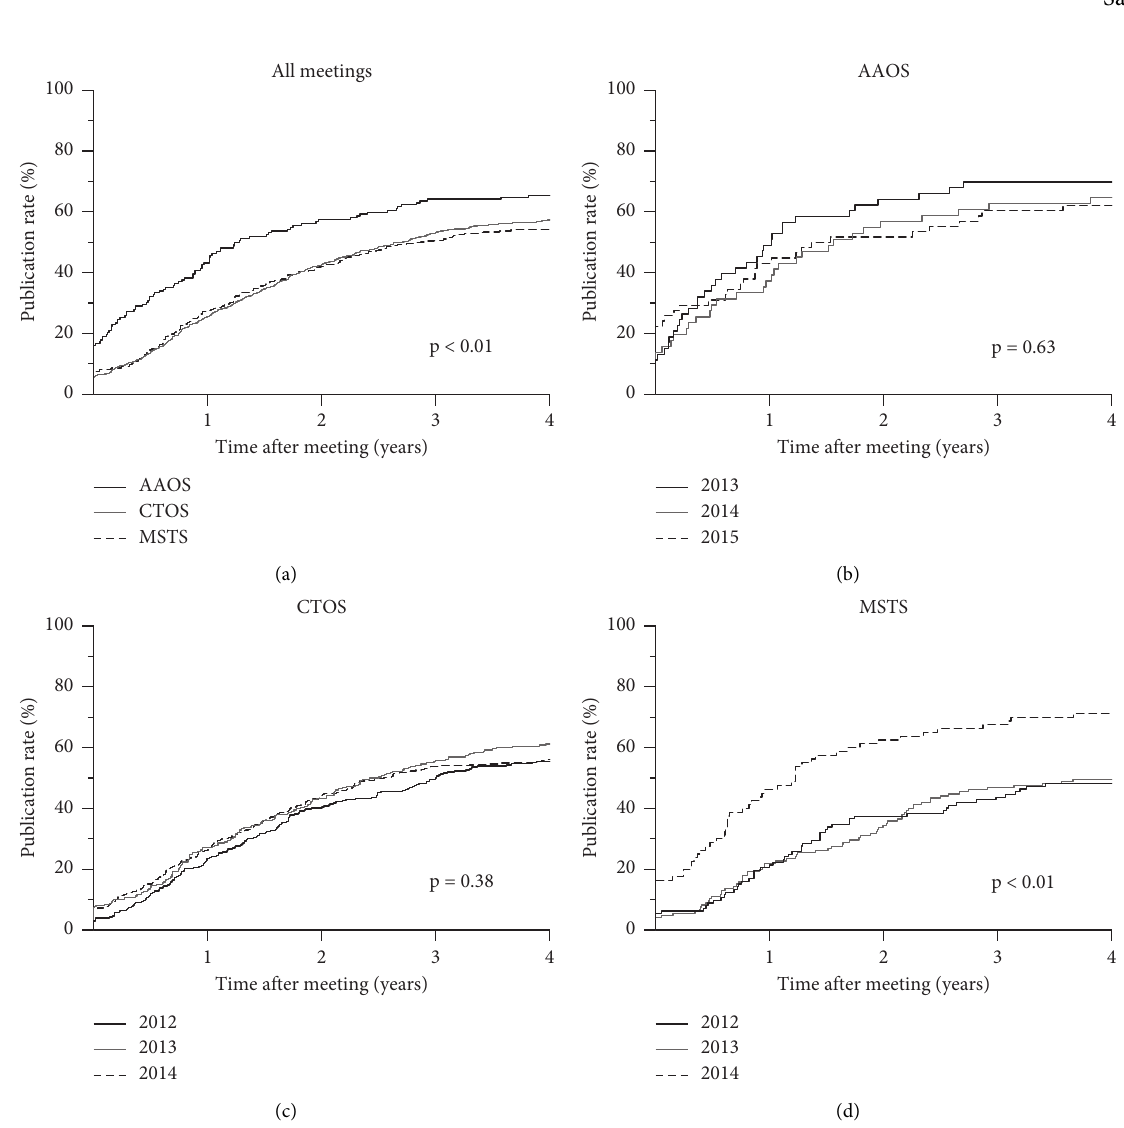
Figure 1: Publication rates over time for oncology abstracts presented at select AAOS, CTOS, and MSTS annual meetings are shown in (a). The publication rates over time are also shown for individual AAOS (b), CTOS (c), and MSTS (d) meetings. Time to publication was calculated as the interval from the first day of the meeting to online publication. Abstracts published prior to the first day of the meeting are depicted by the origin of each line on the y -axis. AAOS indicates the American Academy of Orthopaedic Surgeons; CTOS, Connective Tissue Oncology Society; MSTS, Musculoskeletal Tumor